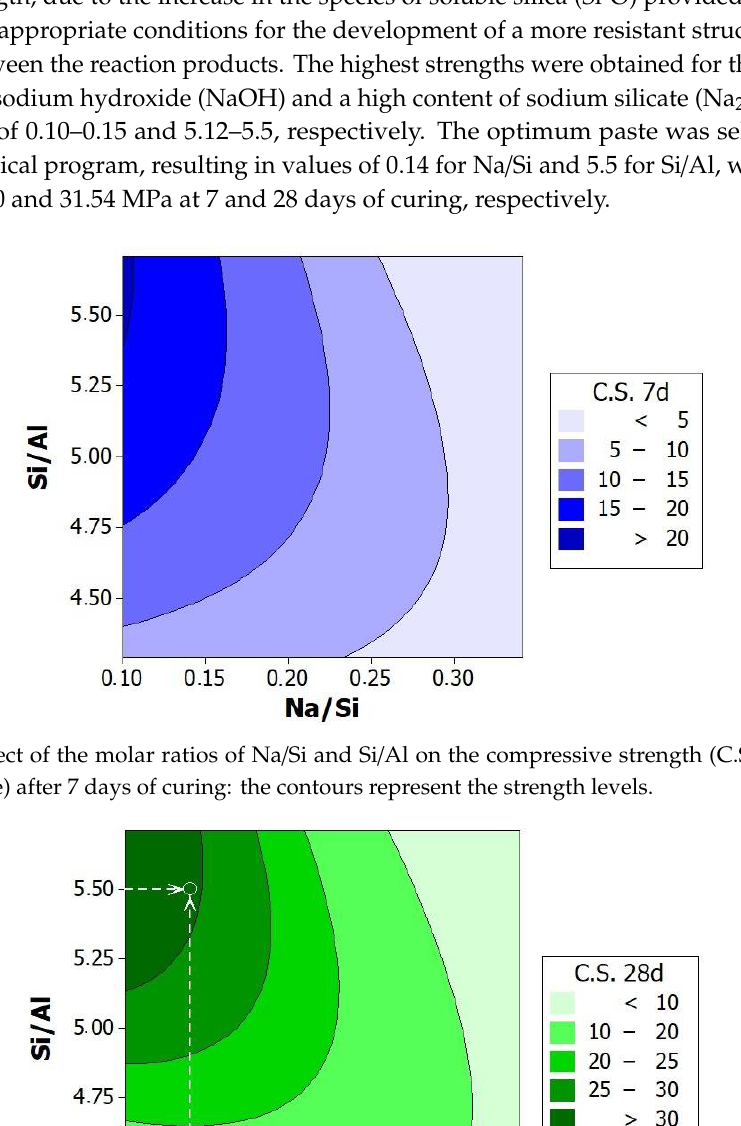
Figure 5. Evolution of the heat of reaction of the pastes.